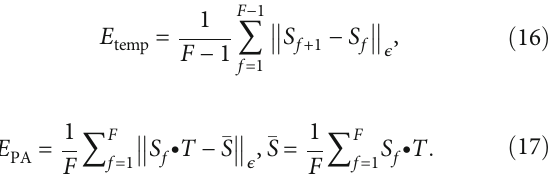
Table 4. Compared with jumping manifolds (JM) [21],